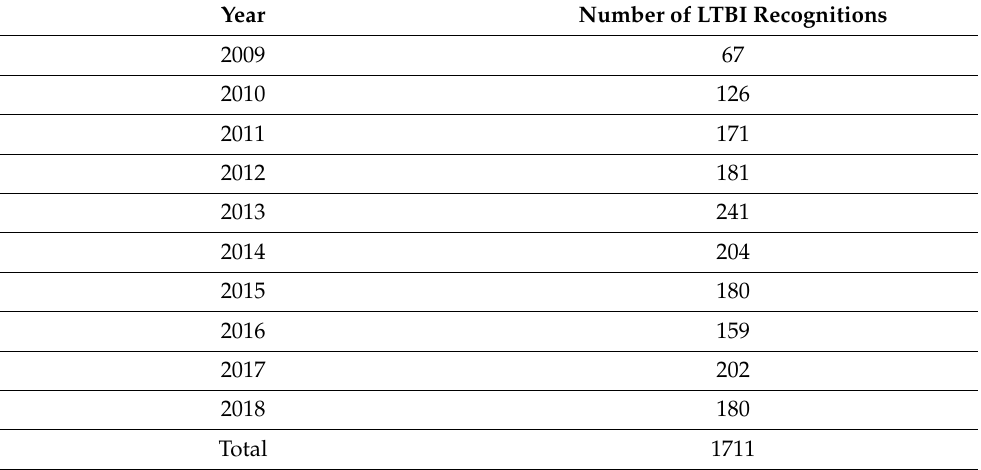
Table 1. Recognised occupational latent tuberculosis infections (LTBI). Data from the German Statuary Institution for Accident Insurance and Prevention for Health and Welfare Services (BGW) for 2009 to 2018 ( n =